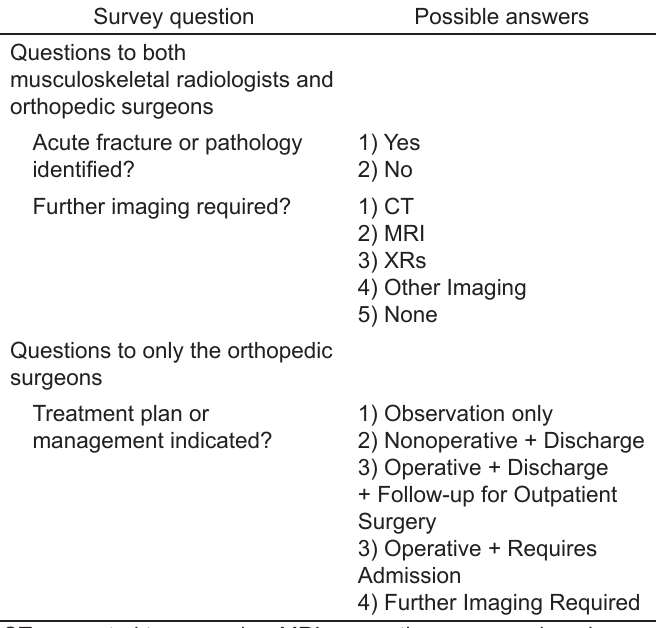
Table 1. Survey format and questions asked for each review of two-view and four-view knee radiographs.